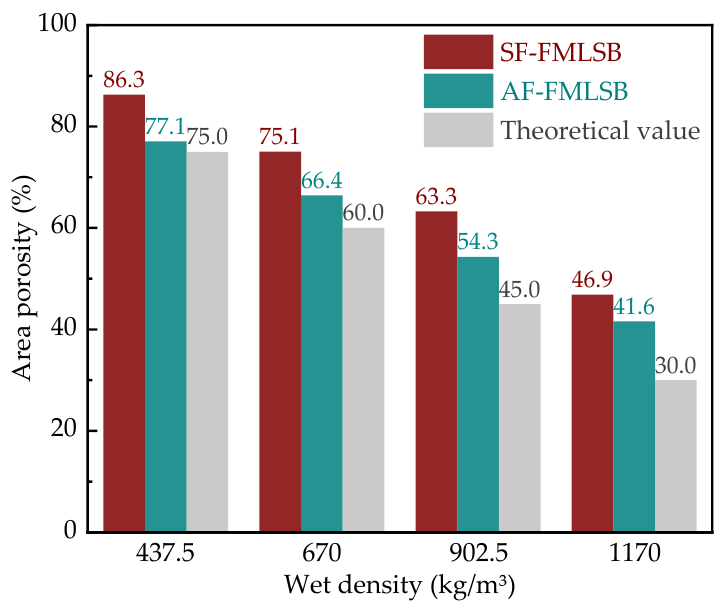
Figure 7. Area porosity of SF-type and AF-type